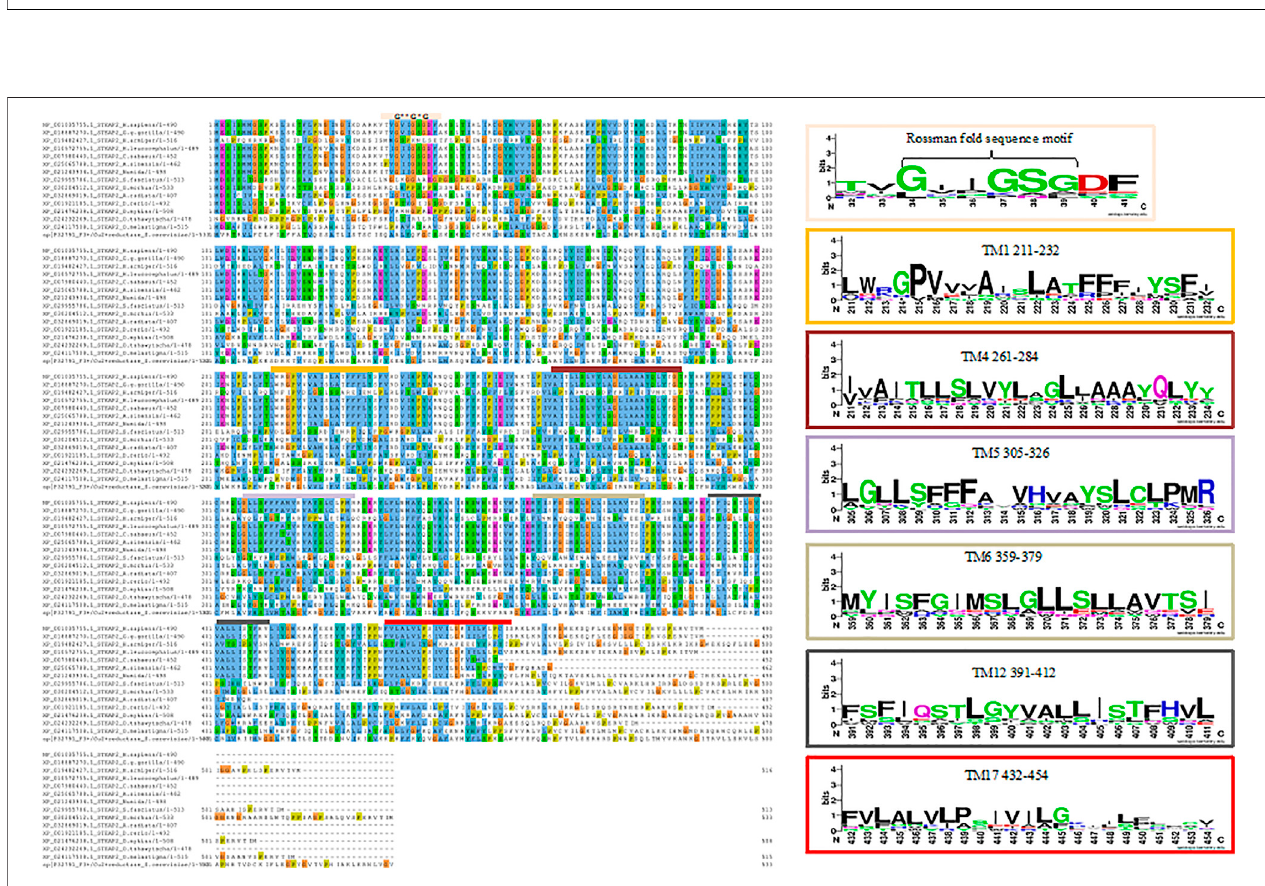
FIGURE 5 | MSA of STEAP2 proteins from 14 species from 4 different classes of chordates. The most conserved residues are associated with functional roles of theprotein.Fromtop,theRossmanfold,analphabetaalphasecondarystructurewithsequenceGxGxxGiscloselyassociatedwiththedinucleotidephosphategroupof NADP followed by the fi rst trans-membrane domain (TM1) (Hanukoglu, 2015). The second, third, fourth, and fi fth TM domains (TM4, 5, 6, and 12, respectively) in close contact with the iron binding TM domain and fi nally the sixth TM domain.